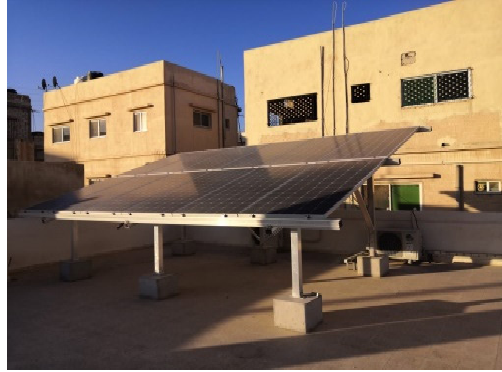
Figure 1. The PV installed at the house, Jordan.